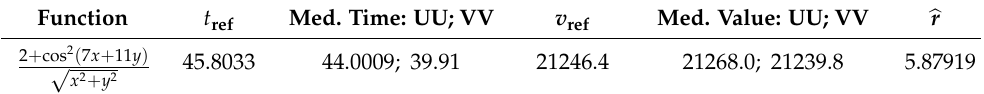
Table 2. Diffusion algorithm example: comparing the parallelised and the nonparallelised versions.